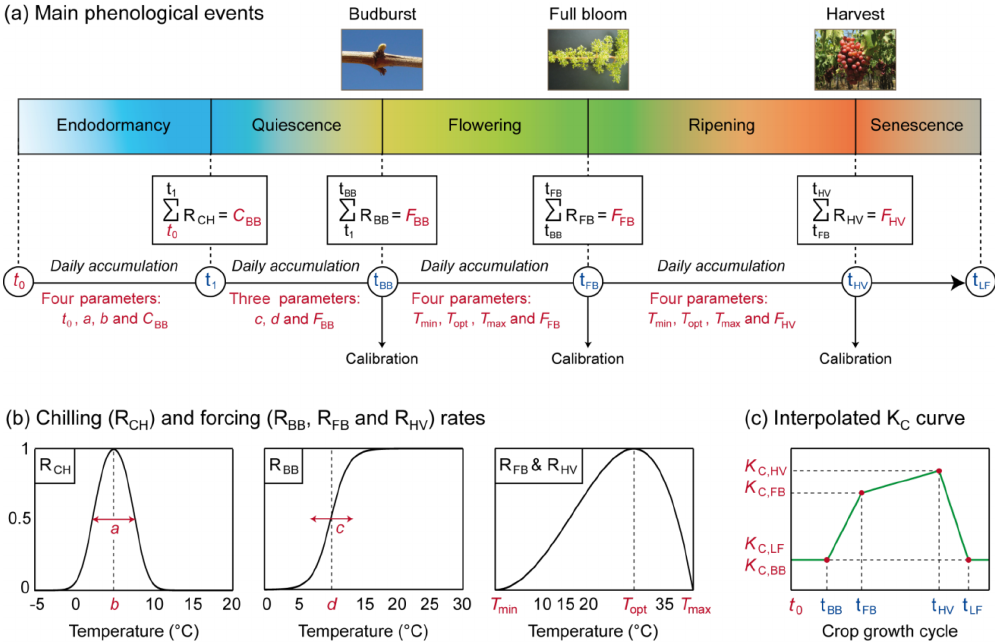
Figure 3. Crop growth and water requirement modeling framework: (a) partitioning of the growing season into five phenophases and pa- rameterization of each phenophase, (b) functions used to express the accumulated chilling and forcing rates over each phenophase, and (c) translation of the simulated dates of budburst, full bloom and harvest into an interpolated K C curve for use in the IWU model. Model parameters are indicated in italic and colored in red. Note that parameters t 0 , c , d , T min , T max , K C,BB , K C,FB , K C,HV and K C,LF were fixed beforehand to avoid